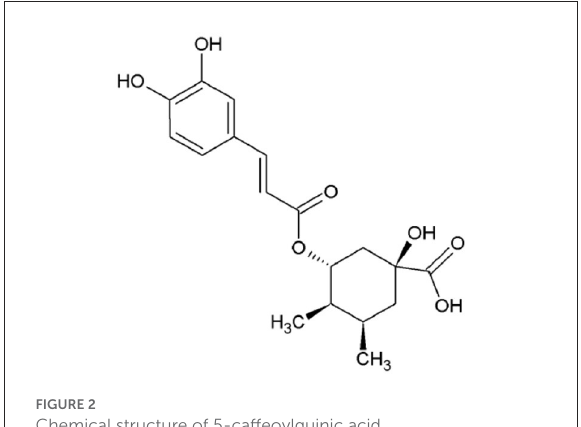
FIGURE2 Chemical structure of 5-caffeoylquinic